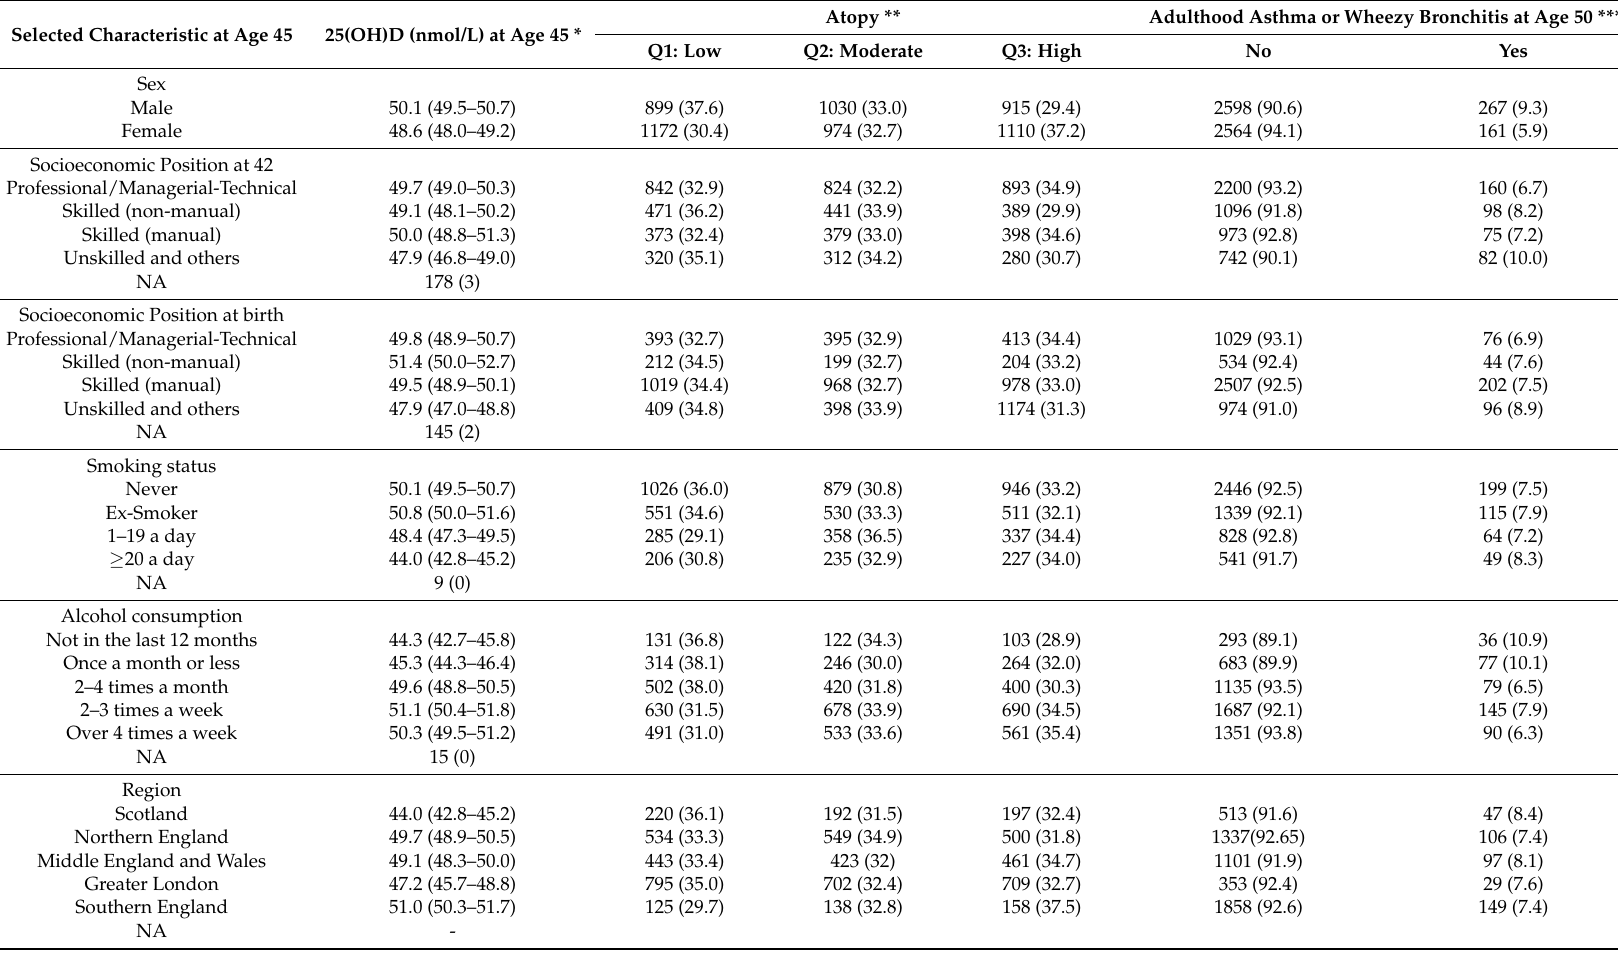
Table 1. Selected characteristics of